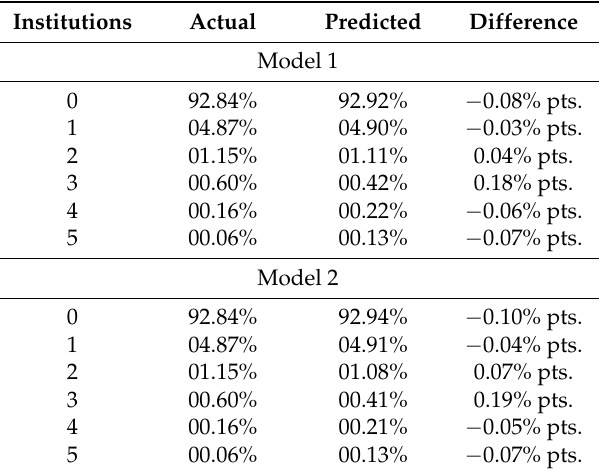
Table 6. Actual count versus predicted count using the